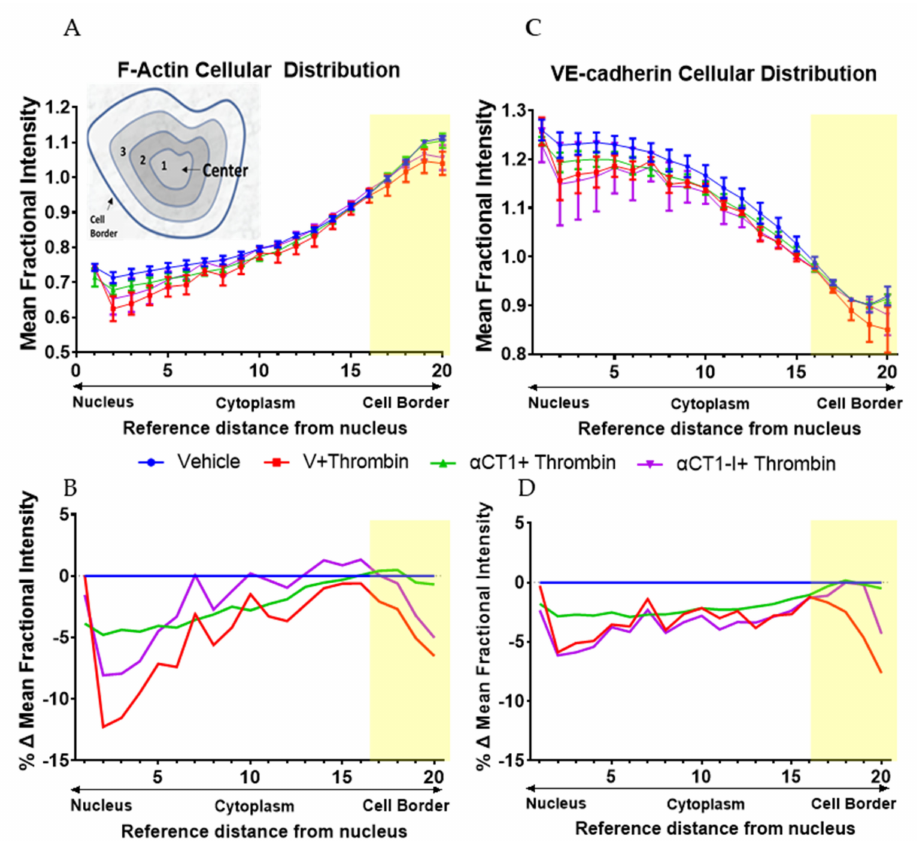
Figure 6. Quantification of α CT1 inhibition of thrombin-induced shift in endothelial F-actin and VE-cadherin distribution in HMEC-1 cells. ( A , C ) The radial distributions of F-actin (top left) and VE- cadherin (top right) were measured as the mean fractional intensity at a given cell radius, calculated as fraction of total intensity normalized by fraction of pixels at a given radius. Cell diagram of regions 1-20 indicated in top left figure. ( B , D ) F-actin (bottom left) and VE-cadherin (bottom right), vehicle- subtracted values calculated as percentage difference from vehicle 100% (Value-Vehicle)/Vehicle). N = 3. Yellow highlighted bar indicates where α CT1+T, but not α CT1-I+T is significant compared to thrombin